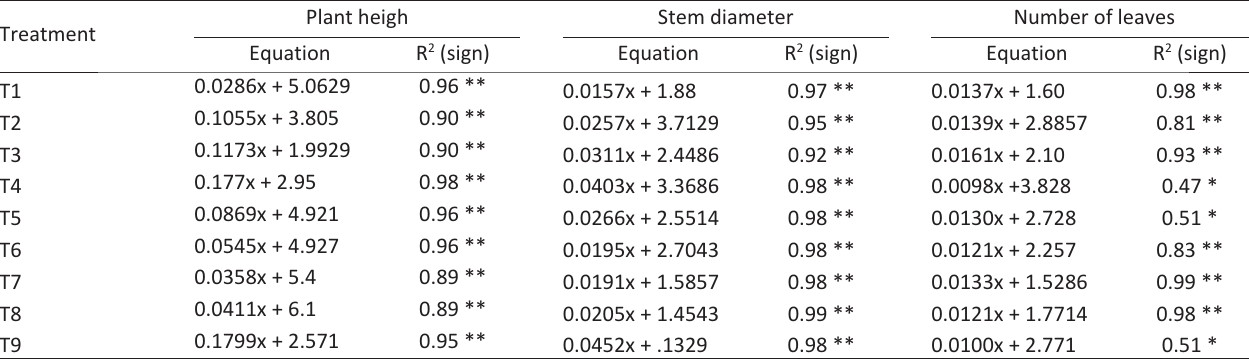
** significative for P<0.01; * significative for P<0.05. T1= sand, T2= commercial substrate (OrganoAmazon © ), T3= 25% T1 + 75%